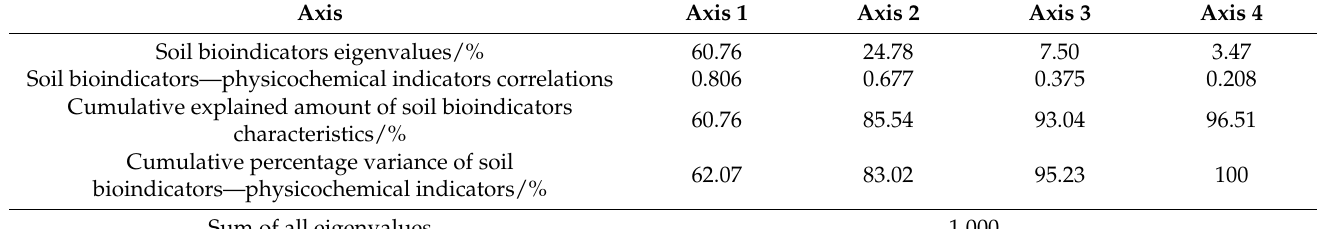
Table 2. Redundancy analysis of the soil bioindicators values and the amount of explanation.